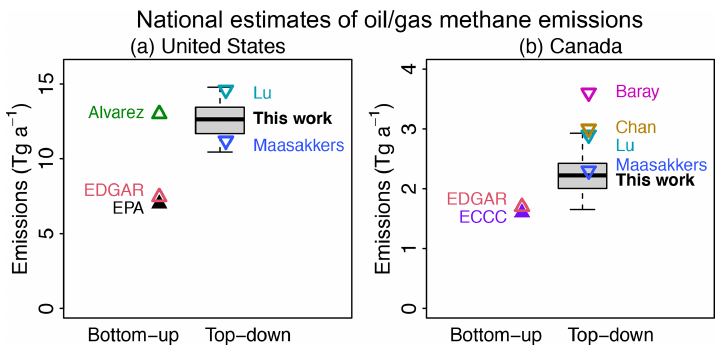
Figure 3. Bottom-up and top-down estimates of national oil and natural gas methane emissions in the US and Canada. Estimates from this work are shown as quantile plots for the inversion ensemble. The top and bottom of the box are the 25th and 75th percentiles, the vertical bars are for the minimum and maximum, and the center line is the 50th percentile. Mean emissions ± 2 standard deviations from the inversion ensemble are 12 . 6 ± 2 . 1Tga − 1 for the US and 2 . 2 ± 0 . 6Tga − 1 for Canada. Symbols show previous estimates, including EPA (2020) for 2018 (which equals the prior estimate for our work), EDGAR v6.0 (Crippa et al., 2020) for 2018, Alvarez et al. (2018) for 2015,